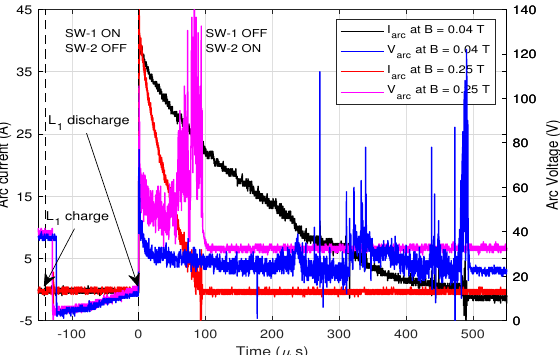
Figure 6. Arc current and voltage versus time at two magnetic induction values, each measured during a single pulse. Arrows indicate PPU coil charge and discharge